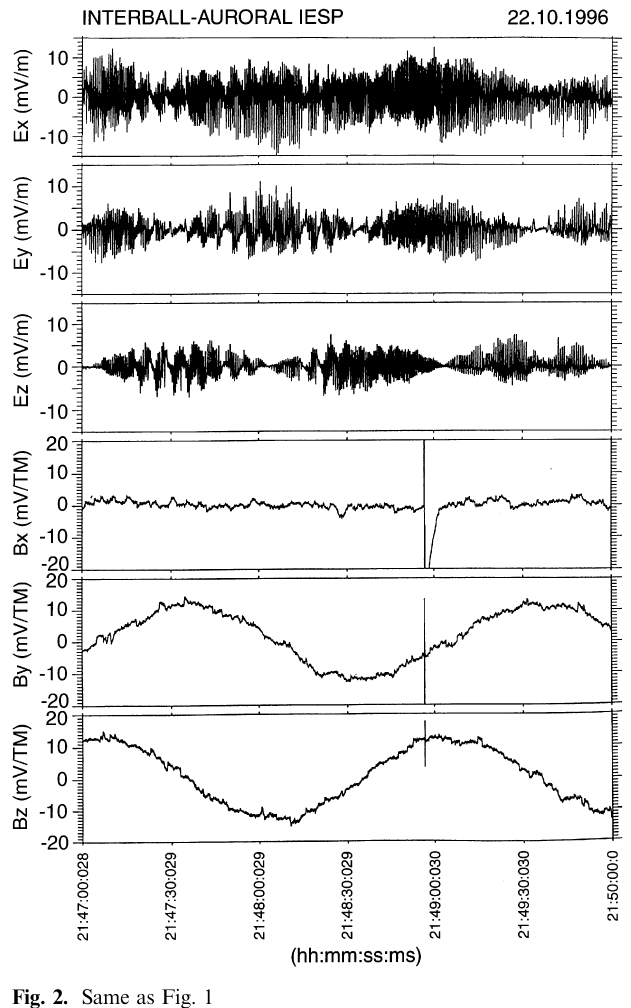
X is 2 min. The S and E at T /2 Y Z S